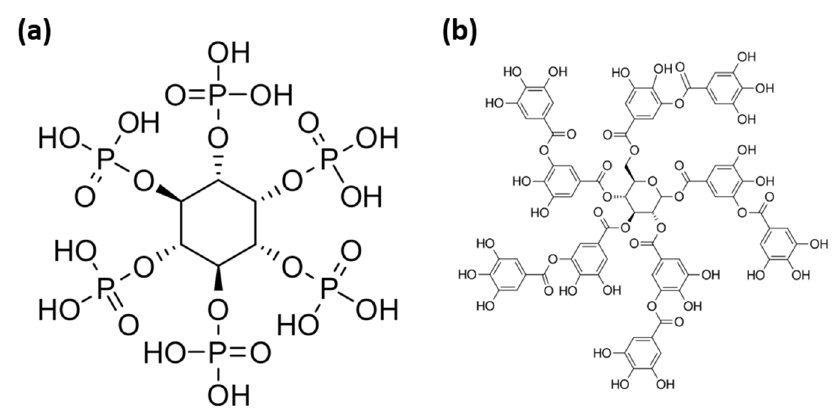
Figure 15. Molecular structure of ( a ) phytic acid and ( b ) tannic acid.